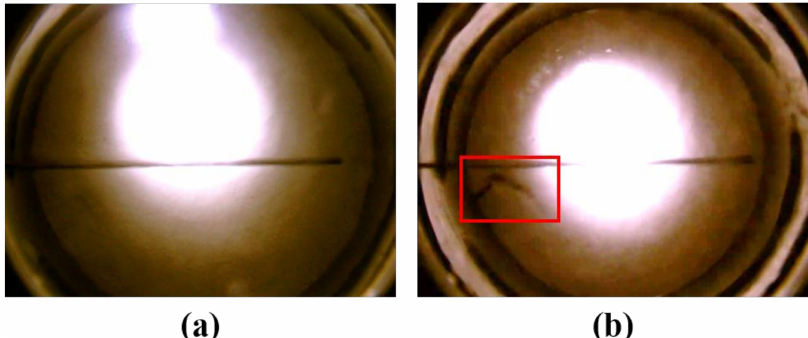
Figure 16. Morphological change of the overlying strata. ( a ) Before depressurization. ( b ) After hydrate